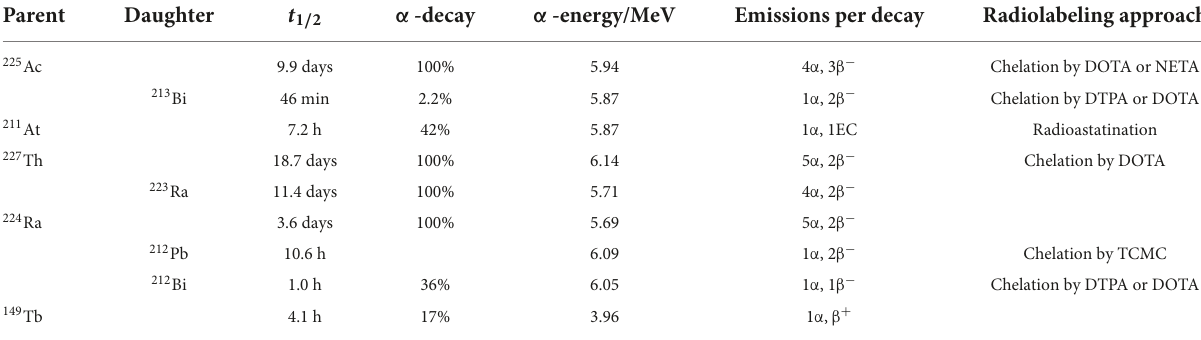
TABLE 2 Medically relevant α -emitters with their decay